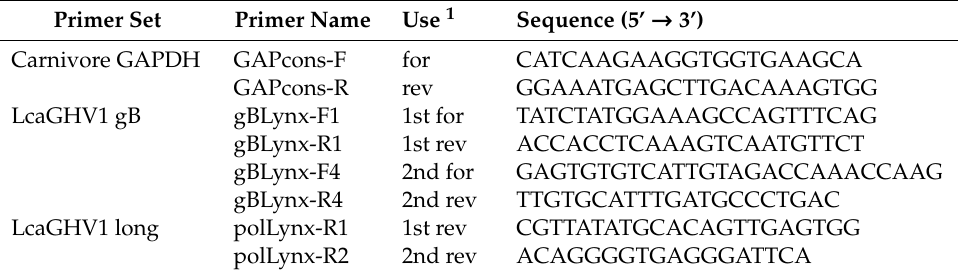
Table 1. Primers designed in this